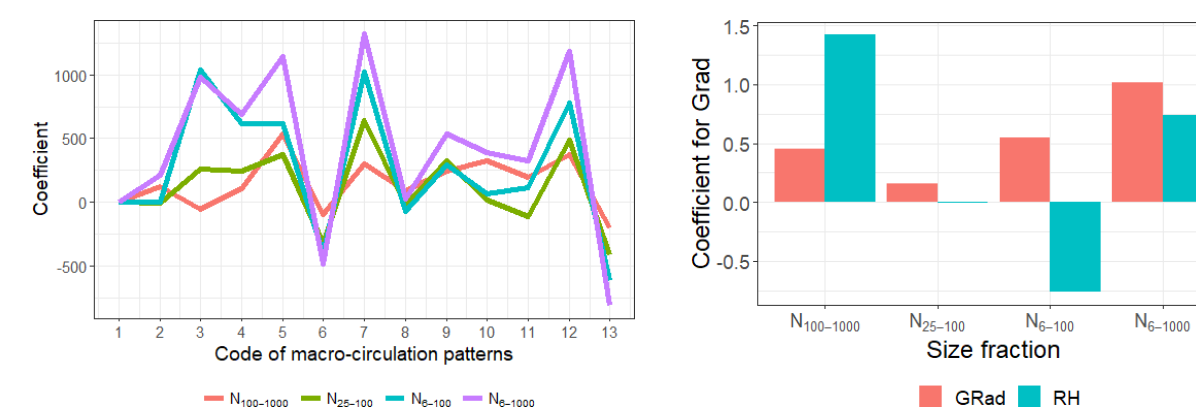
Figure 5. Distribution of monthly-mean coefficients (which are proportional to the partial effects) for macro-circulation patterns (Péczely codes) on particle number concentrations separately in the diameter ranges from 100 to 1000nm ( N 100 − 1000 ), from 25 to 100nm ( N 25 − 100 ), from 6 to 100 nm ( N 6 − 100 ) and from 6 to 1000nm ( N 6 − 1000 ).